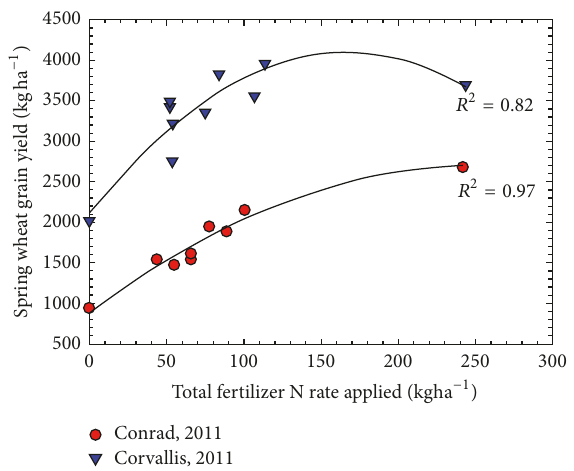
Figure 4: Spring wheat grain yield as affected by total amount of applied N fertilizer, Conrad and Corvallis, MT,